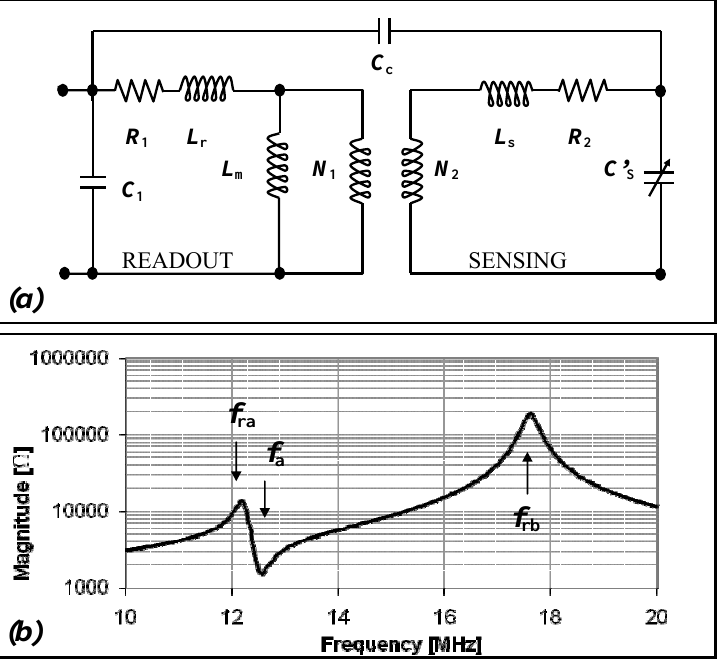
Figure 2. (a) Physical model of an autonomous sensor. (b) Module and phase of the impedance as seen from the terminal of the readout